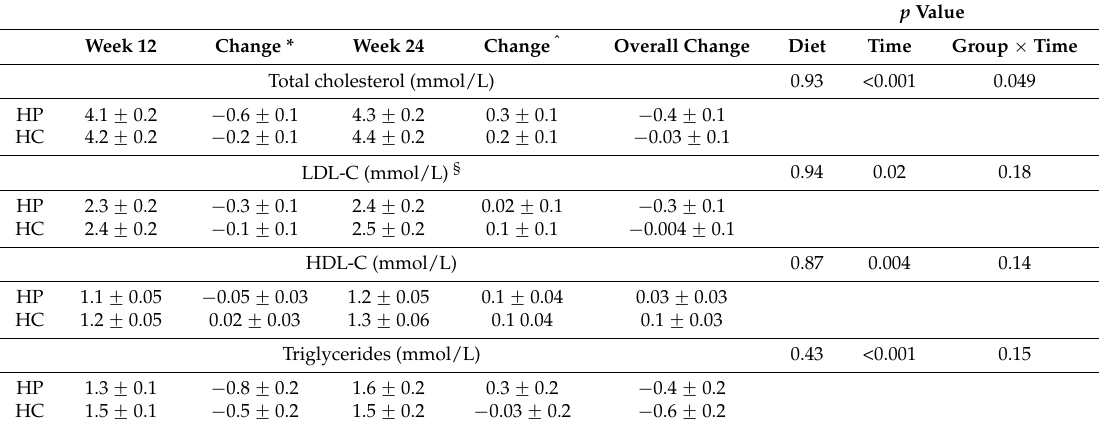
Table 4. Changes in outcomes for blood lipids following 12 weeks weight loss (Week 12) and 12 weeks weight maintenance (Week